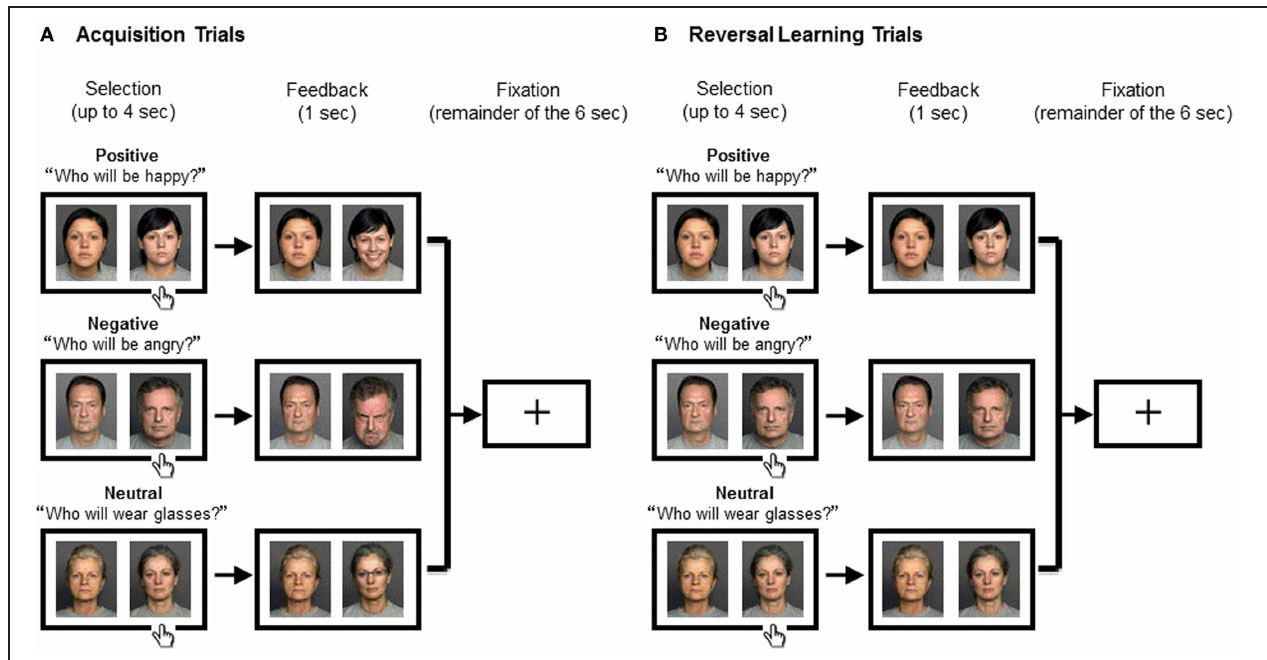
FIGURE 1 | Experimental Procedure. The positive (top), negative (middle), or neutral blocks (bottom) were assigned to the participant in a random order. The two people were randomly assigned to the right or the left of the screen. The trial began with a presentation of two people displaying neutral expressions during which the participant had to select one person by pressing a key. Feedback was presented for 1s, which was followed by a fixation cross for the remainder of the 6s. (A) In Acquisition Trials where the response was